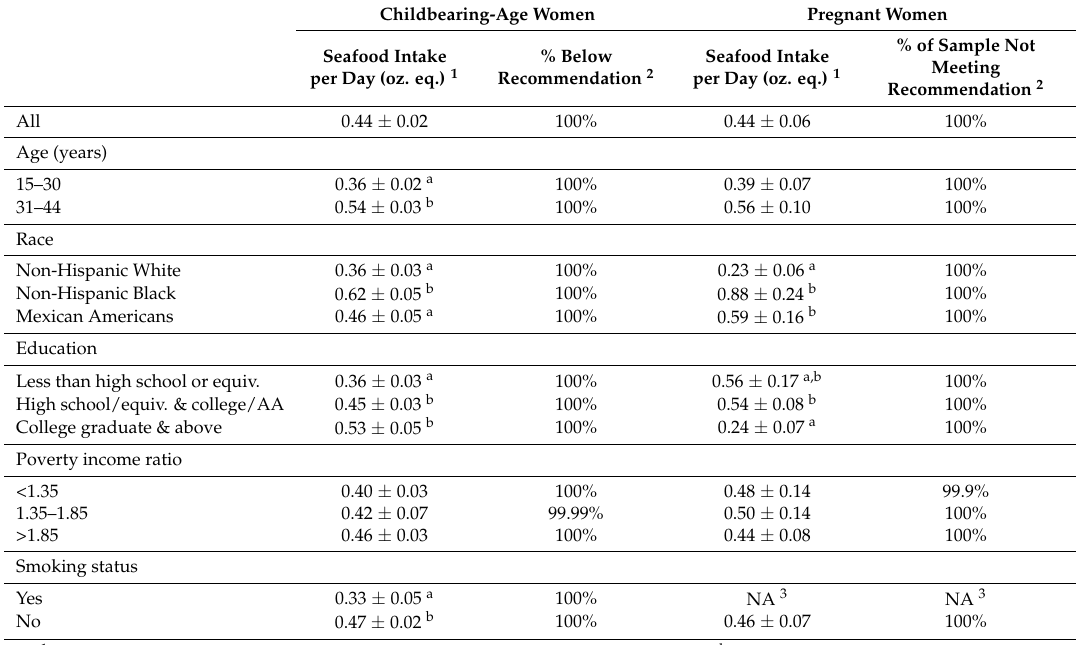
Table 4. Mean usual daily intake of seafood among childbearing-age and pregnant women for a fully qualified sample